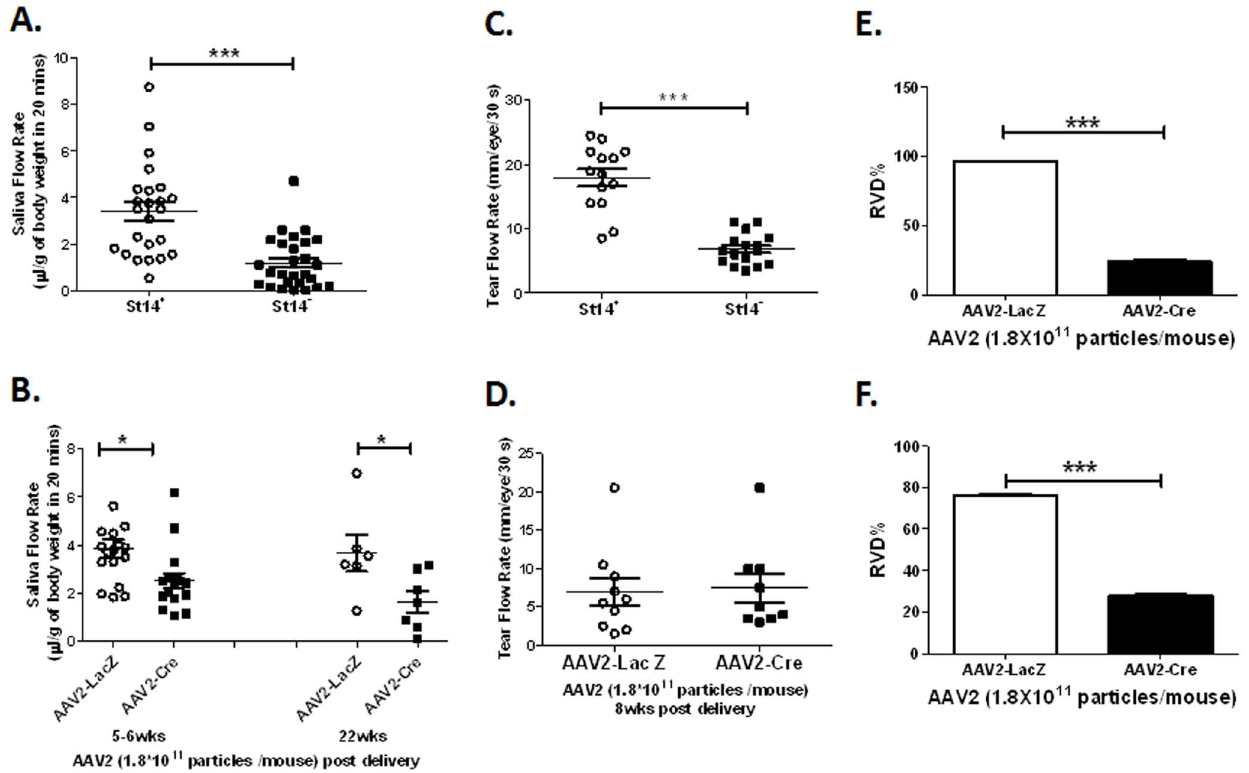
Figure 1. Exocrine gland dysfunction in matriptase-deficient mice. Pilocarpine-stimulated salivary flow rate (SFR) and tear flow rate (TFR) were measured in mice with either embryonic or acute salivary gland ablation of matriptase. (A, C) At 24–54 weeks of age, St14 – mice showed a significant reduction in SFR as well as TFR ( N =27 for SFR and N= 16 for TFR) compared with the littermate St14 + control mice ( N =24 for SFR and N =14 for TFR; *** P , 0.0001). (B, D) AAV2-mediated acute deletion of matriptase led to a significant decrease in SFR in AAV2-Cre animals ( N= 17) compared with the AAV2-LacZ controls ( N= 17) 5–6 weeks after AAV2 administration (* P =0.0126). This decrease in saliva production was stable for at least 22 weeks post AAV2 delivery ( N= 6 in AAV-LacZ and N= 7 in AAV-Cre group; * P= 0.037). At 8 weeks post-AAV2 delivery, TFR was measured revealing no significant changes between matriptase-deficient and control animals ( N= 10 for AAV2-LacZ and N= 10 for AAV2-Cre, P =0.8353). (E, F) SMG ductal and acinar cells RVD% was calculated as the relative cell volume changes after hypotonic solution stimulation. Data shown are the mean 6 SEM for each group. Statistical significance was determined using an unpaired Student’s two-tailed t test. *** P , 0.0001.